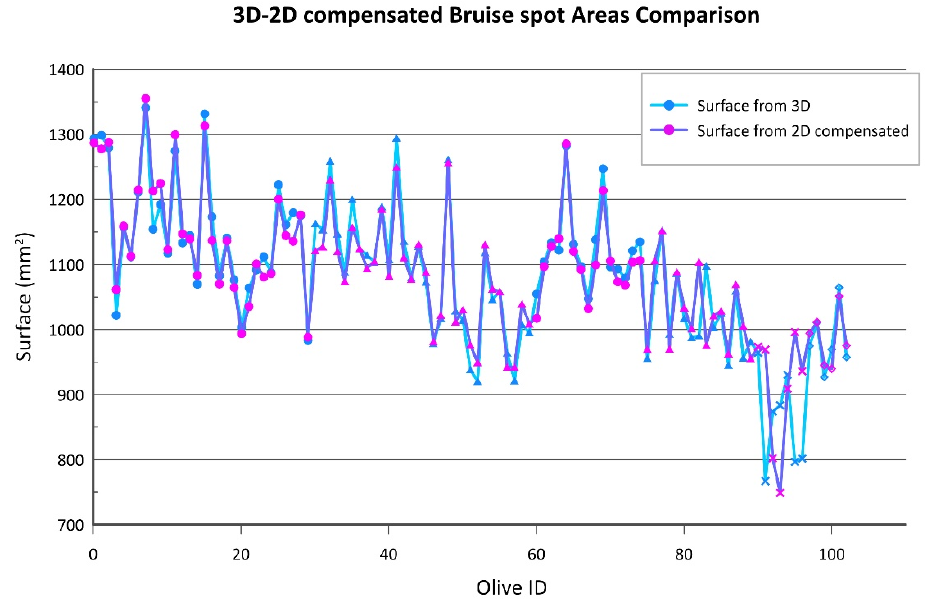
Figure 29. Surface of damage calculated from 3D and 2D image digital analysis multiplied by a 2.93 value.